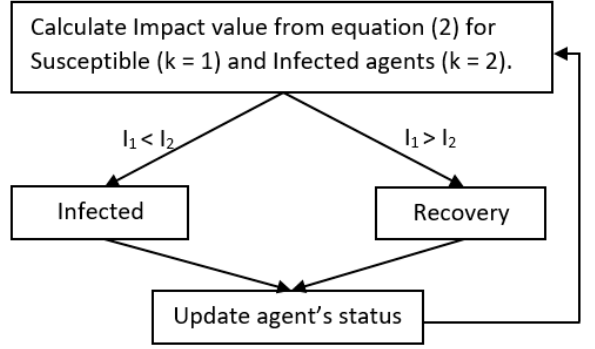
Figure 1. Rumor spreading flow chart.